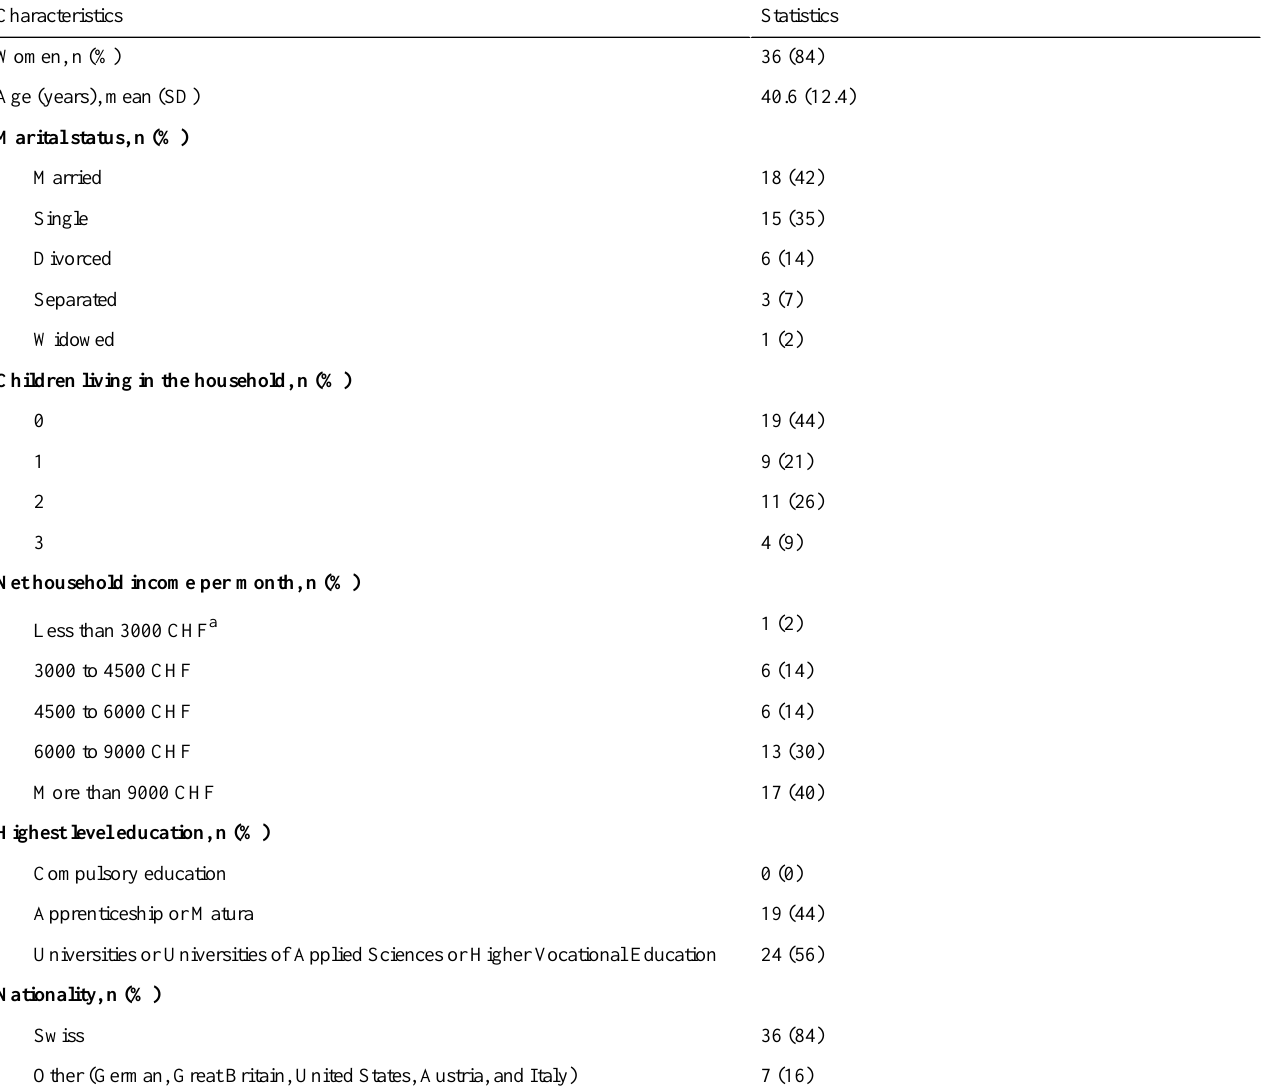
Table 1. Socioeconomic data (N=43).